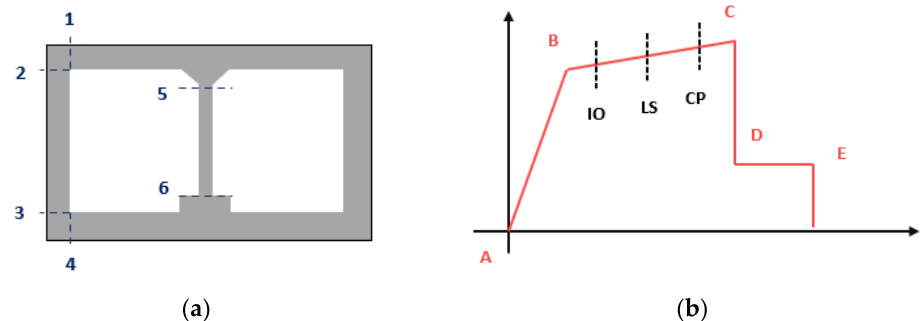
Figure 6. ( a ) Location of hinges for the analysis of rectangular tunnels; ( b ) definition of hinges response and damage states (IO: Immediate Occupancy limit state, LS: Life Safe limit state, CP: Collapse Prevention limit state, redrawn after Huh et al. [76]).